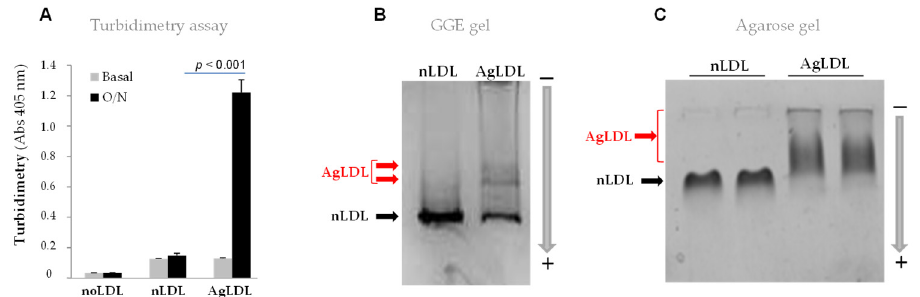
Figure 1. Effects of SMase on human LDL aggregation. ( A ) Bar graph showing the effect of SMase on LDL aggregation (turbidimetry at 405 nm) ( B ) Gradient gel electrophoresis (GGE) and ( C ) Agarose gel electrophoresis showing LDL electrophoretic mobility of AgLDL in comparison to nLDL. Data are shown as mean ± SEM of three experiments performed in triplicate. Statistical significance was determined by Student’s t -test. O/N, overnight; LDL, low-density lipoprotein; nLDL, native LDL; AgLDL, aggregated LDL. Full uncropped blots can be found in Figure S5.